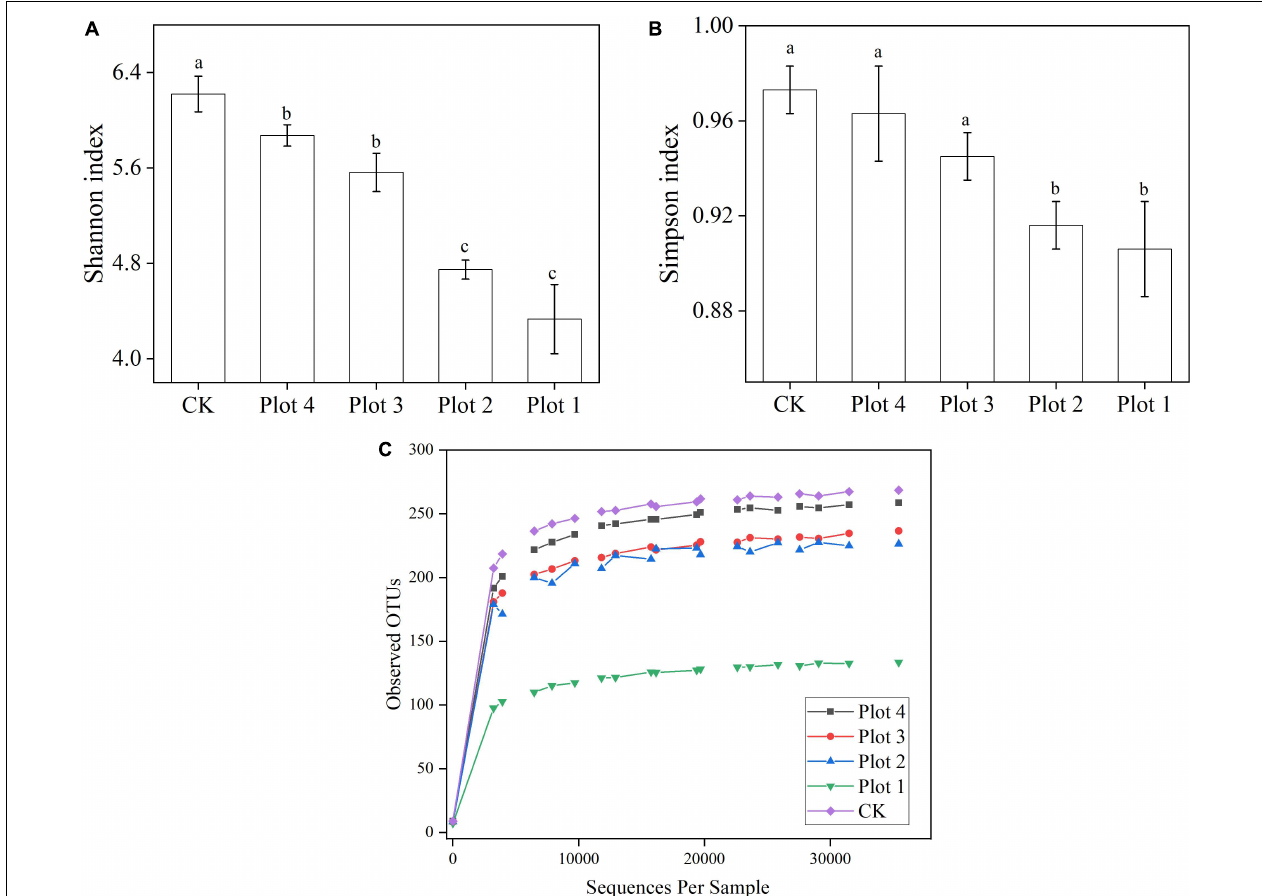
FIGURE 2 | (A) Shannon index, (B) Simpson index, and (C) observed OTUs rarefaction curves of soil fungi in sample plots with different reclamation ages. CK represents soil in a reference plot with native Hippophae rhamnoides vegetation on the mine site, and Plot 4, Plot 3, Plot 2, and Plot 1 represent soils